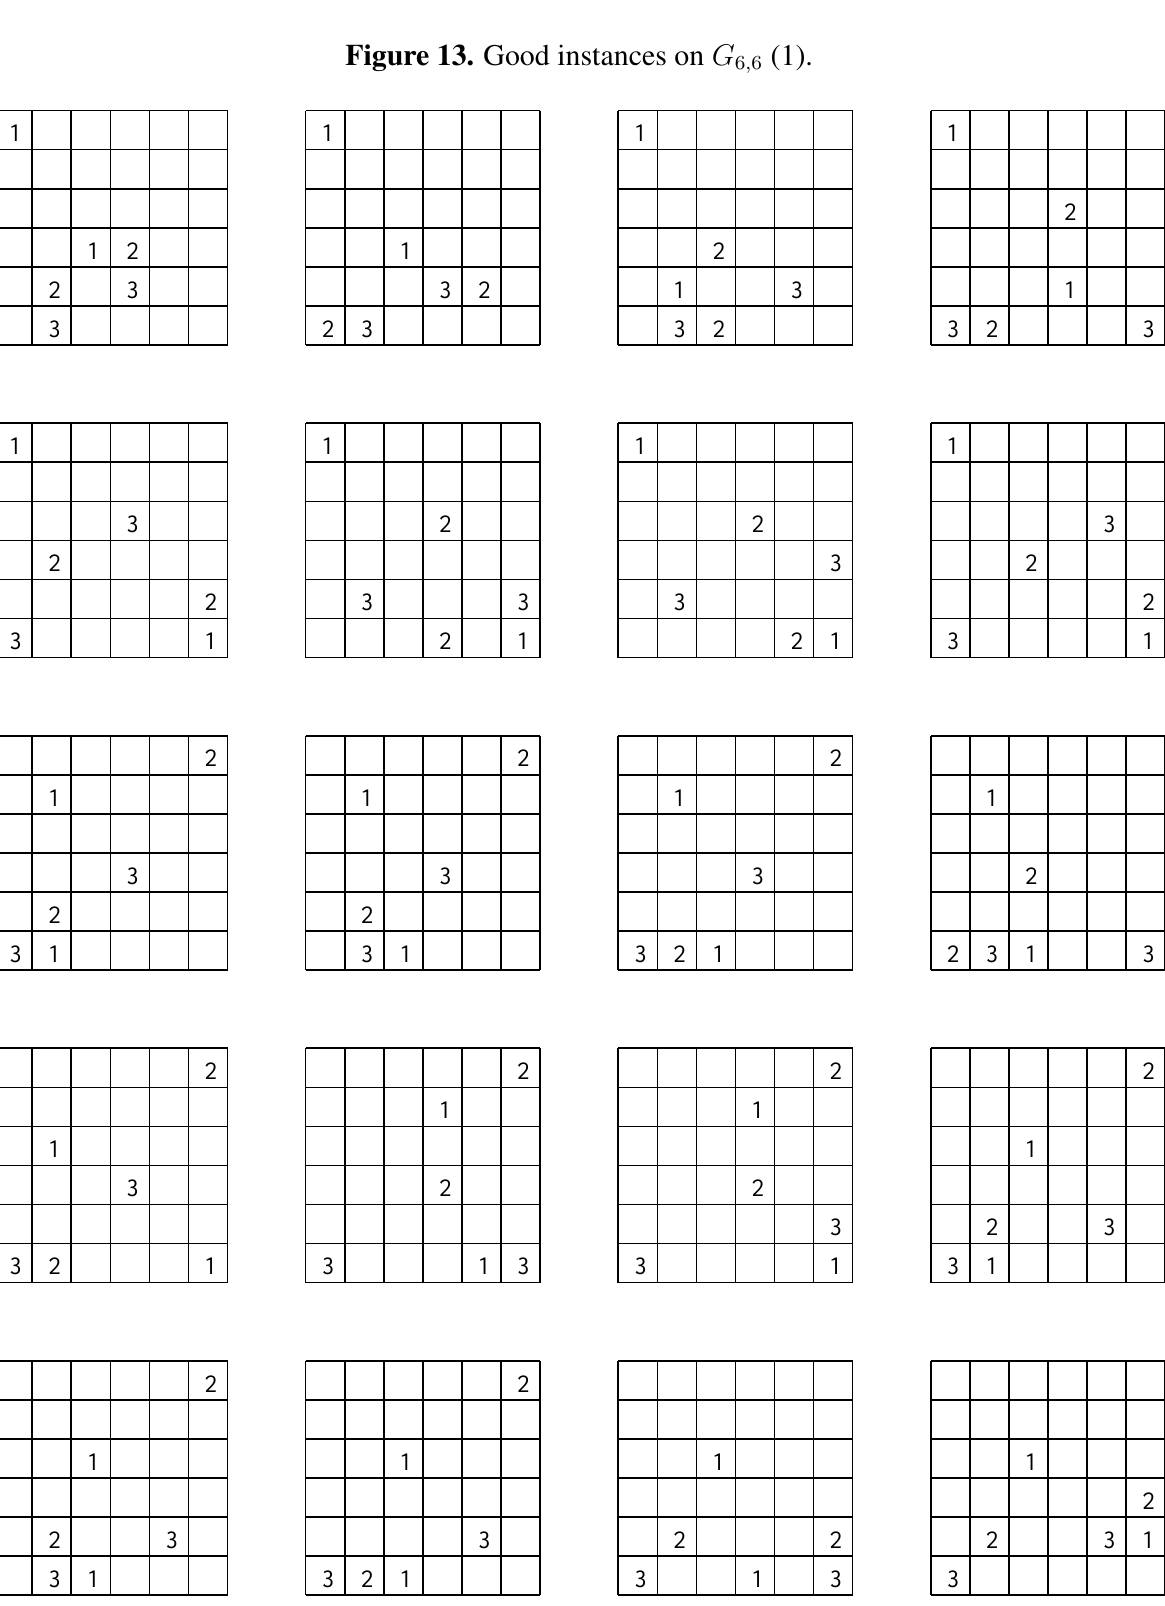
Figure 13. Good instances on G